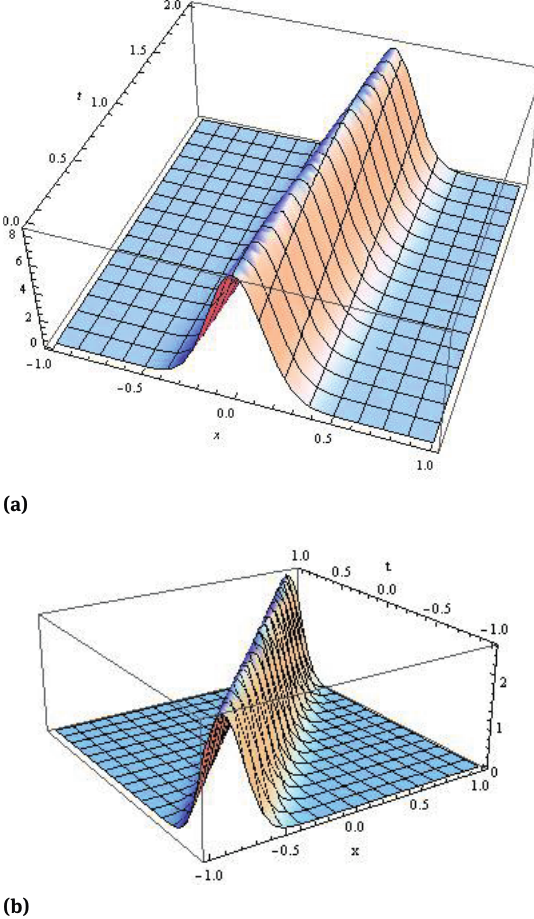
Fig. 3: Solitary waves of generalized soliton KGZ equation when, m = 5, n = 1 and k = 50 (a) U = 0.1 (b) U = 0.9